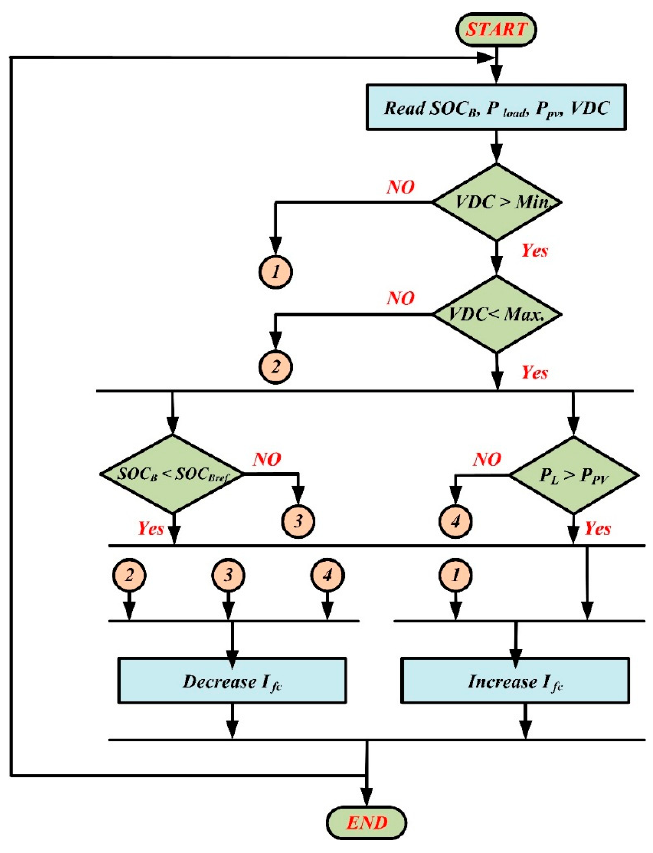
Figure 12. Fuel cell current control flow chart.